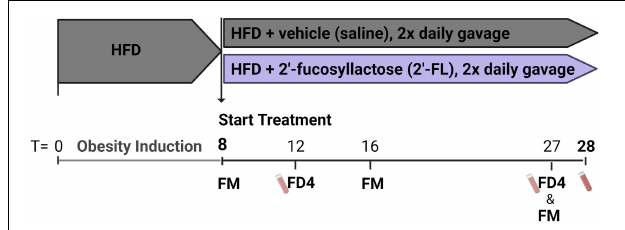
FIGURE 1 | Ldlr–/–.Leiden mice were pretreated with a HFD for 8 weeks to induce an obese phenotype with hyperinsulinemia. These mice were then divided into two groups. One group of mice was treated with 2 (cid:48) -fucosyllactose (2 (cid:48) -FL) by oral gavage twice daily (750 mg/kg/day) until week 28, and subsequently compared with HFD + vehicle control mice receiving twice daily saline ( n = 18/group). At week 8, 16 and 27 feces were collected for 16S microbiota profiling (fecal microbiota; FM). Blood samples were taken at week 12 and 27 for gut permeability measurements (FD4) and in week 28 sacrifice plasma was